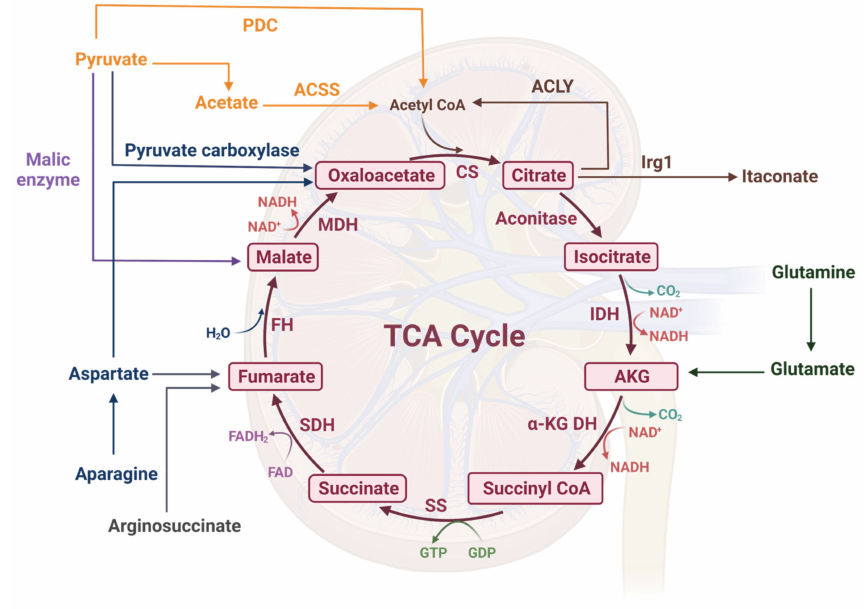
Figure 1. The tricarboxylic acid (TCA) cycle. The TCA cycle is an amphibolic route with anabolic and catabolic reactions. Anaplerotic reactions include the net input of amino acids in the cycle and the generation of oxaloacetate from pyruvate through pyruvate carboxylase. Among the main products of the TCA cycle are guanosine triphosphate (GTP), dinucleotide nicotinamide molecules